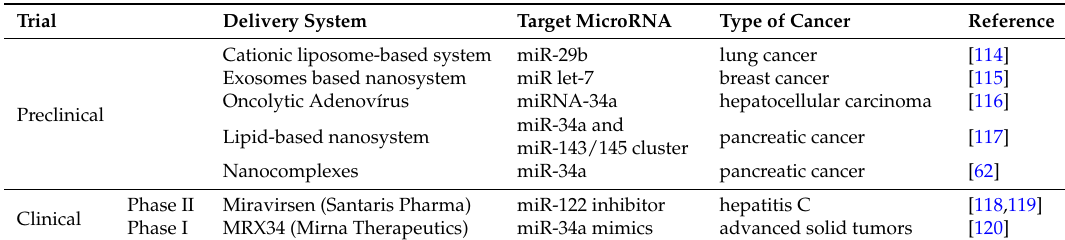
Table 3. MicroRNA-based antitumor strategies in preclinical and clinical